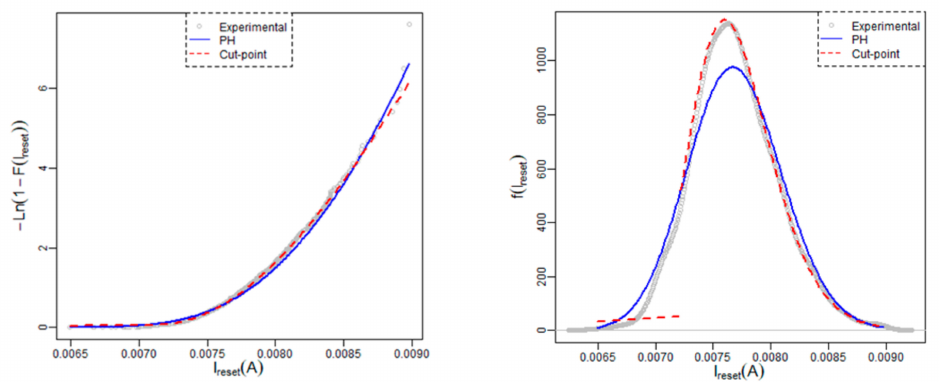
Figure 5. Cumulative hazard rate ( left ) and probability density function ( right ) for 1000 reset current values, and the corresponding PH and cut-point PH